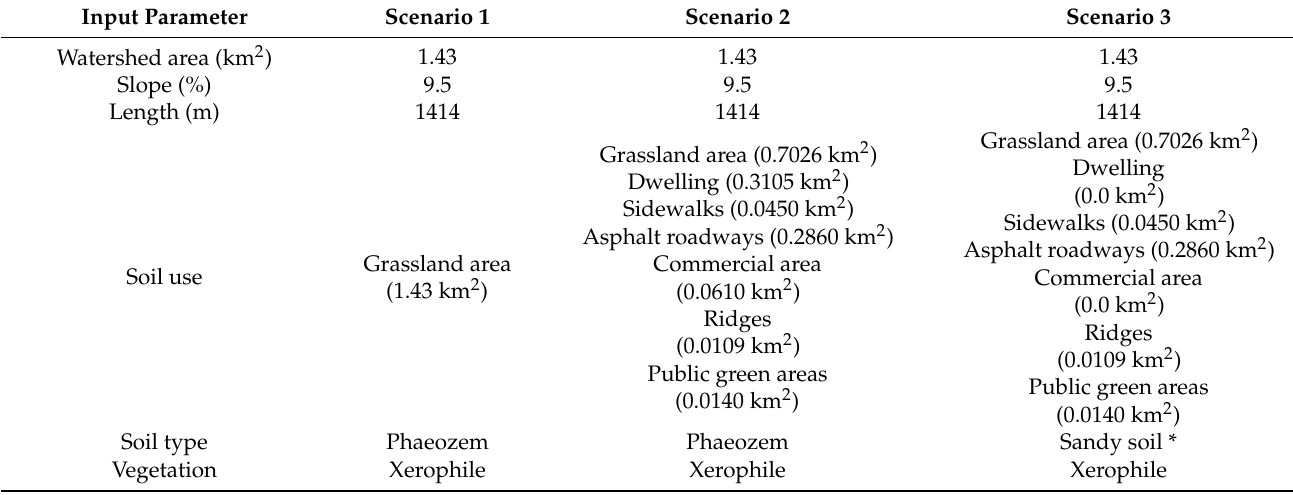
Figure 3. Urban scenarios analyzed: ( a ) existing gray infrastructure (scenario 2), and ( b ) gray infrastructure plus conservation measures (rainwater harvesting) at the dwelling scale, and green infrastructure (bioretention systems, infiltration trenches) in private and common green areas (scenario 3). Pw, potable water; Raw, sewage; Rw, rainwater; Iw, infiltration; Evt, evapotranspiration; Smw, stormwater; Pow, polluted runoff; I T , infiltration trench. Table 1. Input parameters of proposed scenarios to determine their flooding mitigation and self-consumption potential. Input